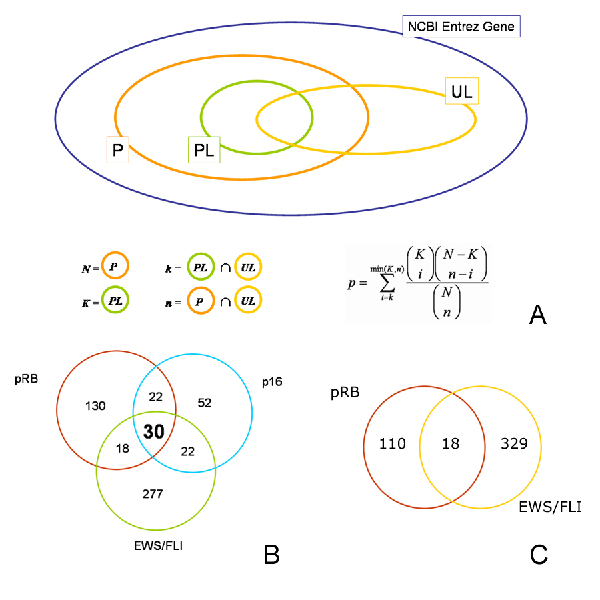
Identification of published lists enriched in p16/pRB regulated genes. (A) Each circle in the figure represents a set of NCBI Gene identifiers (whole set, blue circle). The significance of the amount of NCBI Gene identifiers in common (k) between p16 or pRB regulated genes (UL, yellow circle) and one published list (PL, green circle) is evaluated using the hypergeometric distribution (the formula is reported in right bottom corner of panel A). For each platform (P, orange circle) we annotated the subset of NCBI Gene identifiers that are present on the platform used in the published work (N). The significance of the overlap is estimated considering only NCBI Gene identifiers present in the user list and the P platform (n). (B) Venn diagram representing the overlap of NCBI Gene identifiers repressed by pRB, p16, and EWS/FLI (C) Venn diagram representing the overlap of NCBI Gene identifiers induced by pRB and repressed by EWS/FLI.